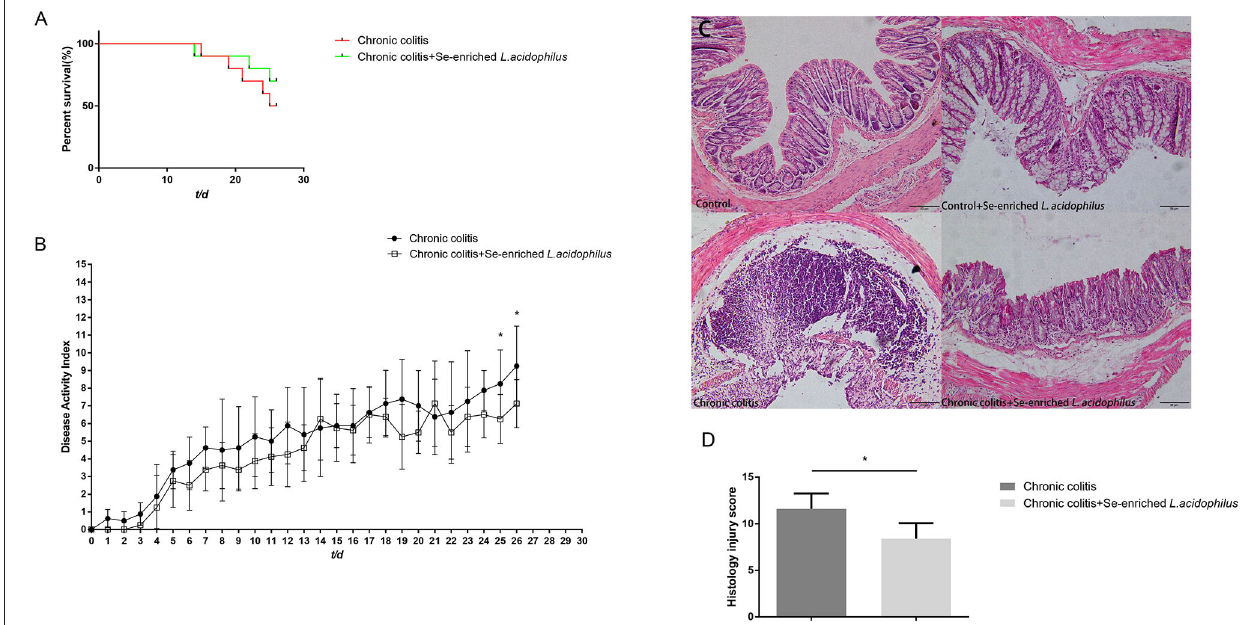
FIGURE 1 | (A) Survival rates between the chronic colitis group and the chronic colitis + Se-enriched L. acidophilus group ( n = 10); (B) Chronic colitis group and chronic colitis + Se-enriched L. acidophilus group DAI scores ( n = 8); (C) H&E staining of colon tissue of four groups. (200 × ) (Control) There were no inflammatory cells infiltration. (Control + Se-enriched L. acidophilus ) There were no inflammatory cells infiltration. (Chronic colitis) Numerous neutrophil and mononuclear cells infiltration could be found. (Chronic colitis + Se-enriched L. acidophilus ) There were fewer neutrophil and mononuclear cells infiltration than chronic colitis group. (D) Histological injury scores between the chronic colitis group and the chronic colitis + Se-enriched L. acidophilus group ( n = 5). Data are expressed as the mean ± standard error ( * P <